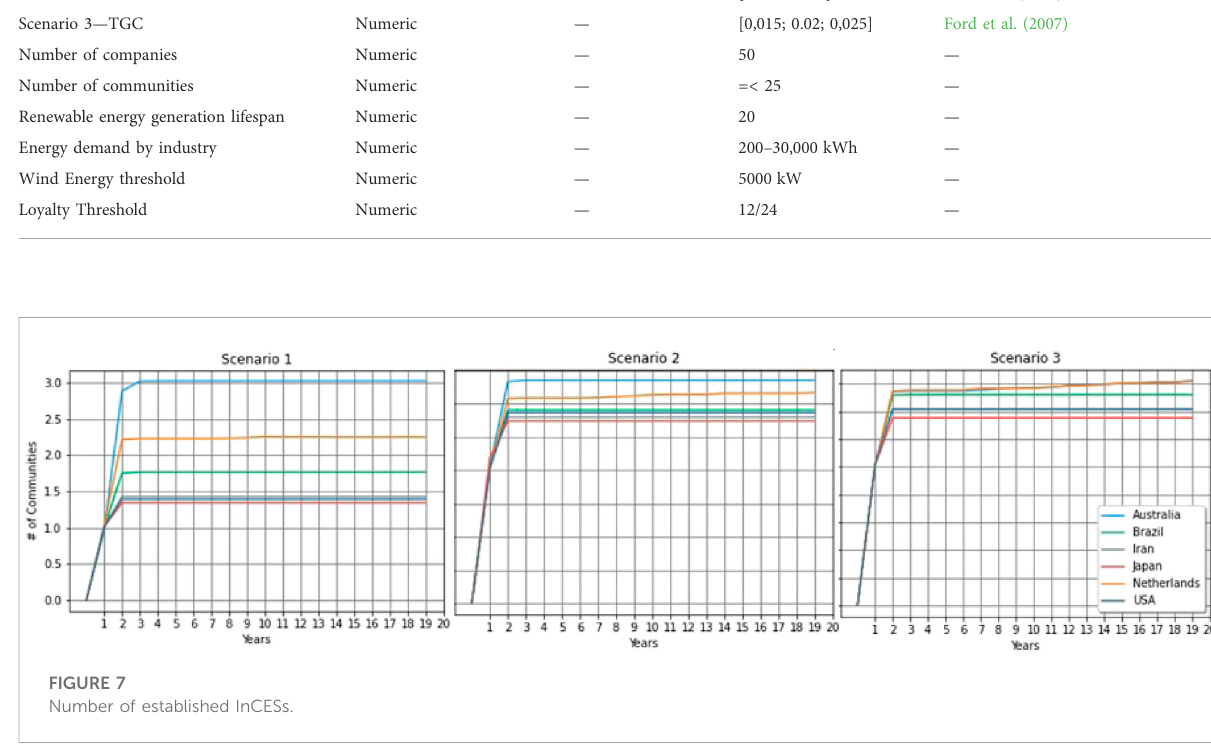
TABLE 5 Number of established